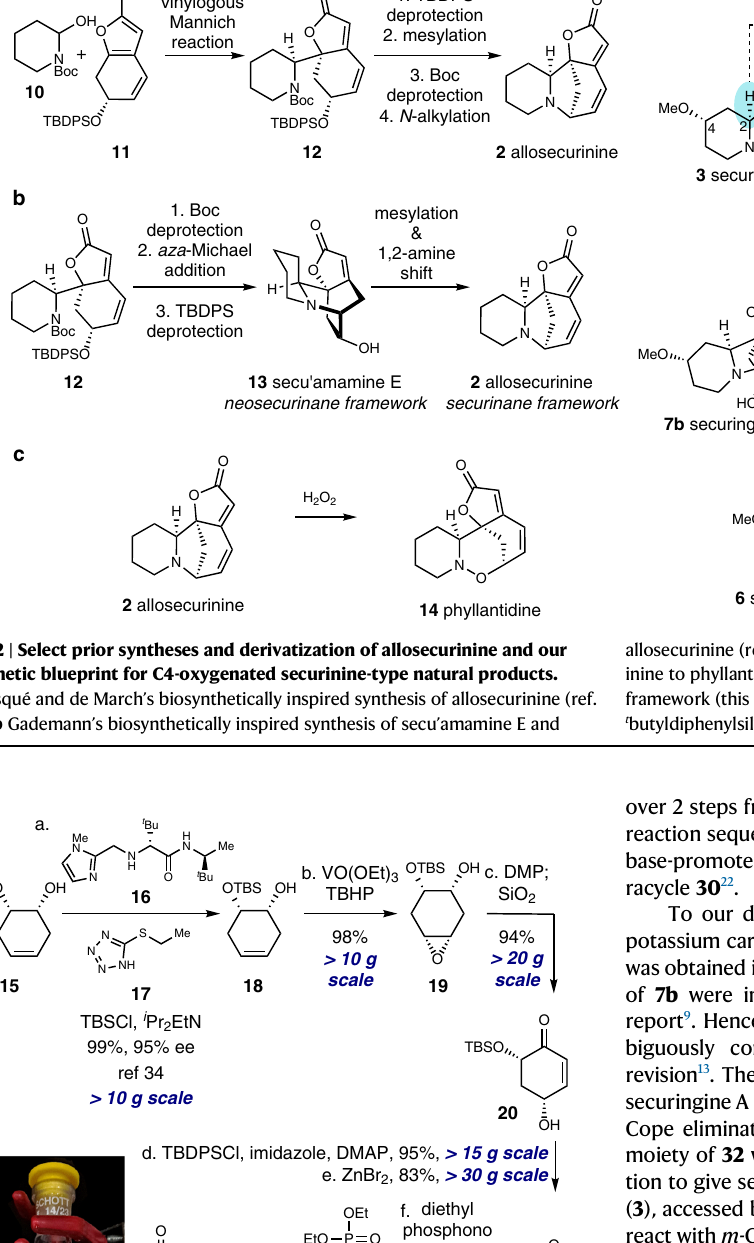
Fig. 3 | Synthesis of O-tbutyldiphenylsilylmenisdaurilide (23). Reagents and conditions: (a) 16 (0.2 equiv), 17 (0.1 equiv), TBSCl (2.0 equiv), i Pr 2 EtN (1.2 equiv), THF, – 40°C, 99% (95% ee); (b) VO(OEt) 3 (0.05 equiv), TBHP (4.0 equiv), CH 2 Cl 2 , 0°C to 23°C, 98%; (c) DMP (1.25 equiv), CH 2 Cl 2 , 23°C; SiO 2 , 94%; (d) TBDPSCl (1.2 equiv),imidazole(1.2equiv),DMAP(0.1equiv),CH 2 Cl 2 ,0°Cto23°C,95%;(e)ZnBr 2 (5.0 equiv), H 2 O (5.0 equiv), CH 2 Cl 2 , 50°C, 83%; (f) diethylphosphonoacetic acid (2.0 equiv), EDCI (2.0 equiv), CH 2 Cl 2 , 23°C, 96%; (g) K 2 CO 3 (5.0 equiv), 18-crown-6 ether (5.0 equiv), THF, 0°C, 61%. TBS t butyldimethylsilyl, TBHP t butyl hydroper- oxide, DMP Dess – Martin periodinane, DMAP 4-dimethylaminopyridine, EDCI